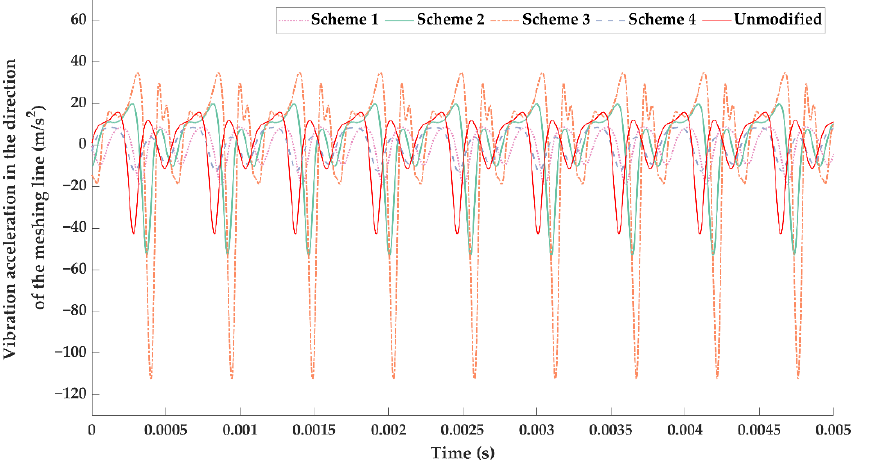
Figure 21. Vibration acceleration in the direction of the gear meshing line at a load of 150 N·m.